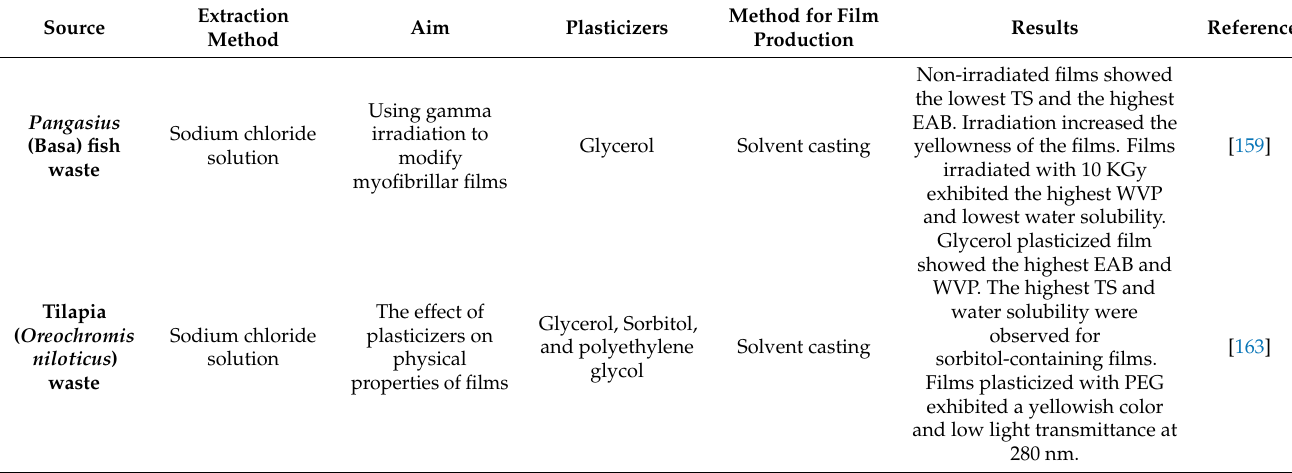
Table 5. Myofibrillar protein films developed from different animal by-product